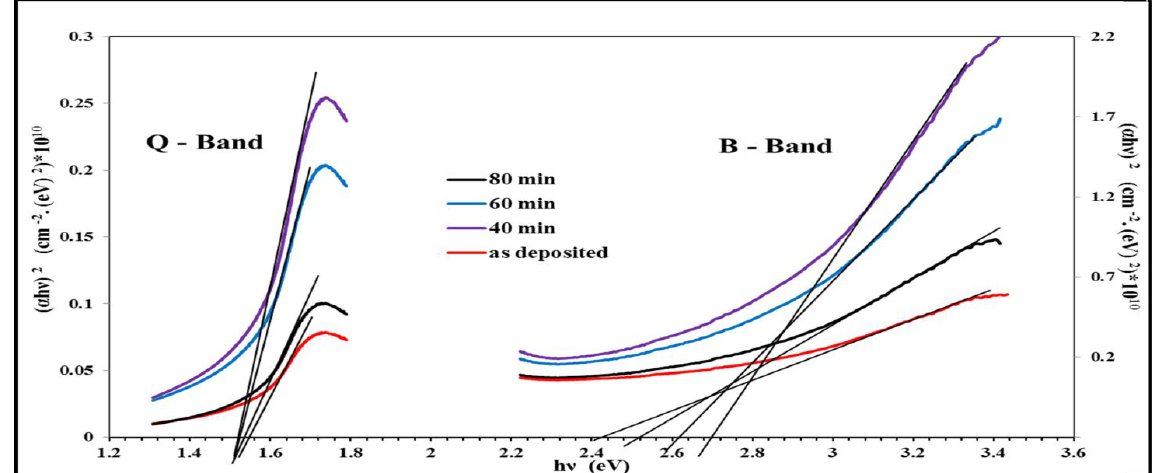
Fig. 8: (αhv) 2 versus hv for the blend CuPcTs/PEDOT:PSS thin films chemically treated with Chloroform at different time for Q band.